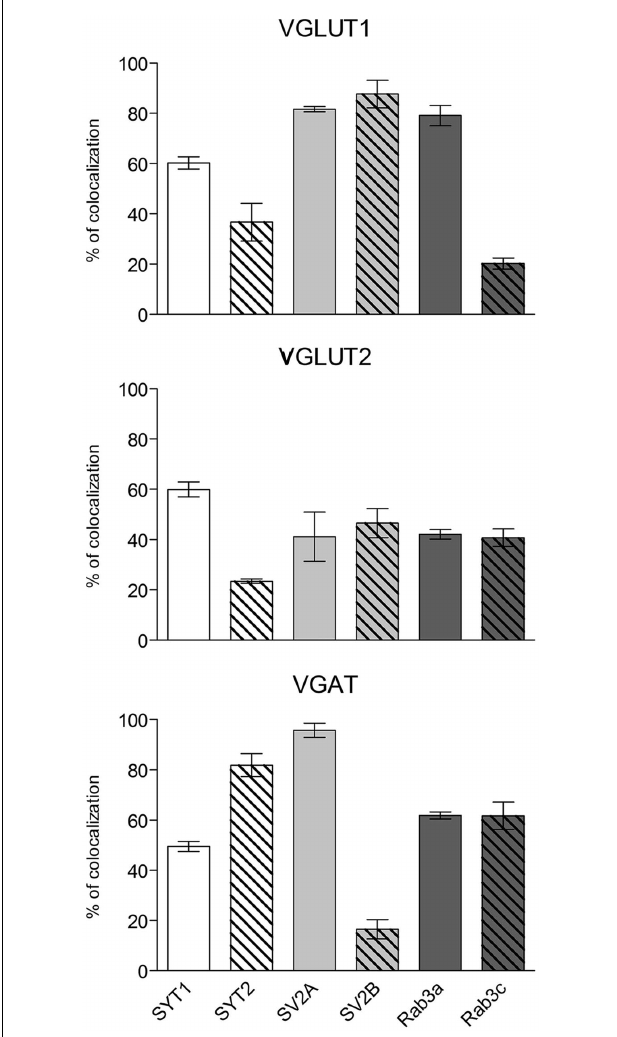
FIGURE 3 | Co-localization of SYT1, SYT2, SV2A, SV2B, Rab3a, and Rab3c inVGLUT1 + ,VGLUT2 + , andVGAT + axon terminals in cerebral cortex. Values (means ± SEM) refer to the percentages of total puncta positive for the respective protein isoform for each of the three terminal populations identified based on the specific vesicular